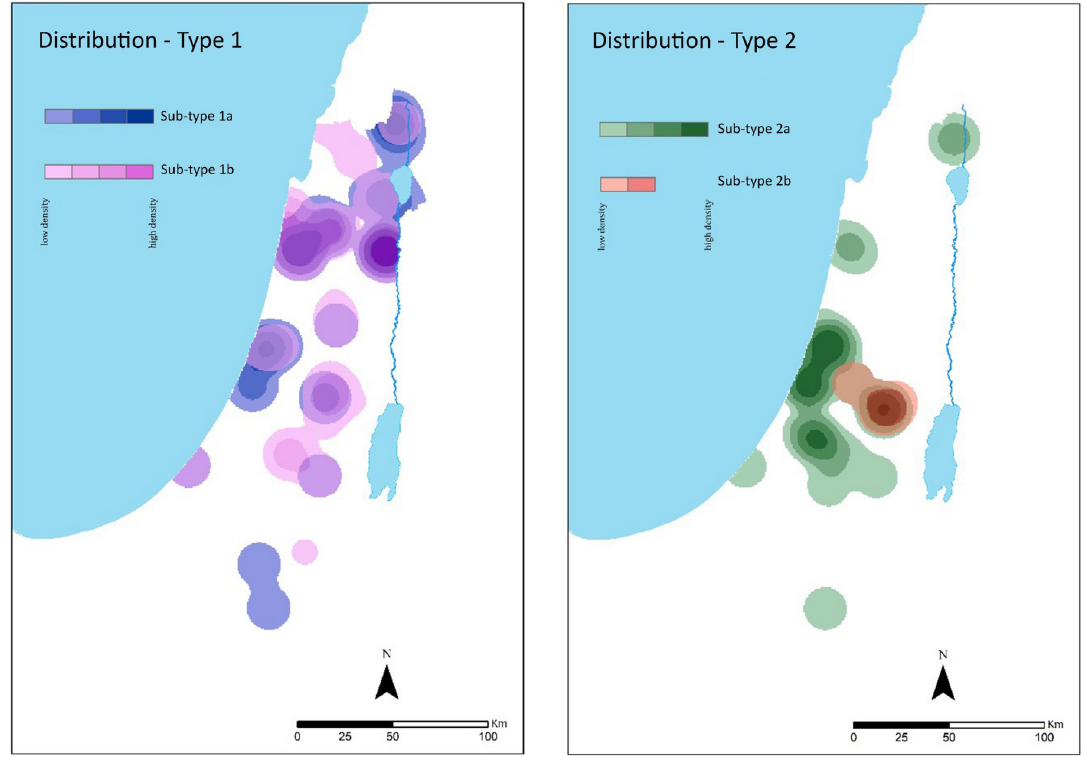
Fig 6. Density maps with ARCMAP showcasing the distribution of types 1 (left) and 2 (right) with their